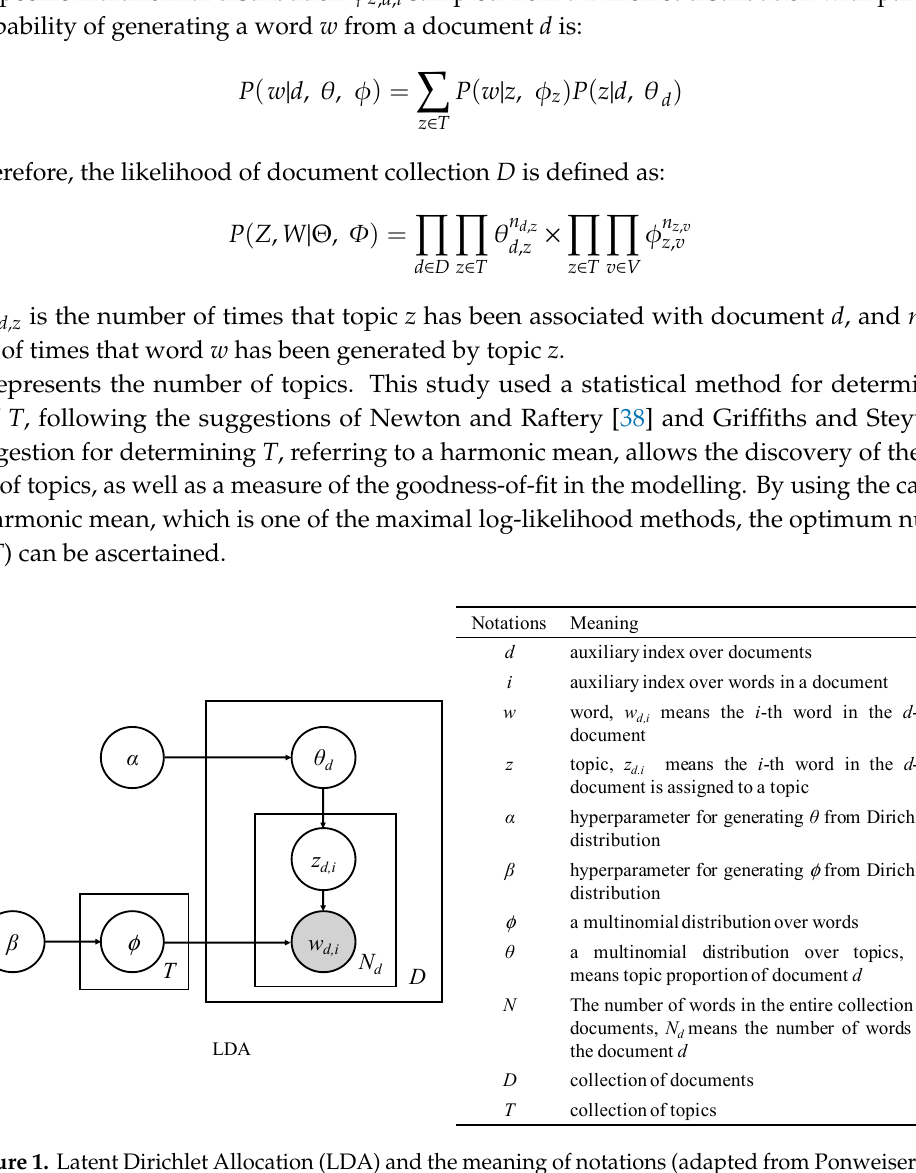
Figure 1. Latent Dirichlet Allocation (LDA) and the meaning of notations (adapted from Ponweiser [39], and Hu et al.